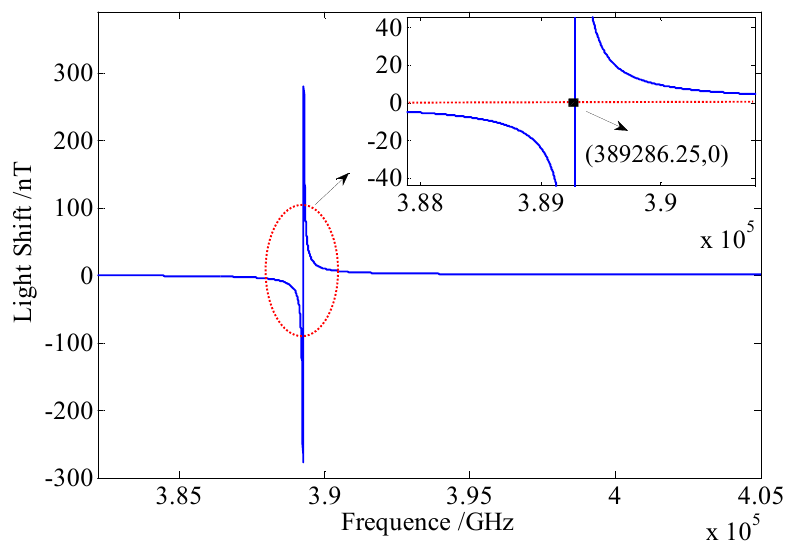
Figure 4. Simulation of the relation between the light shift and the frequency of the pump laser. The power of the pump laser is 100 mW, and the frequency at the resonant peak of potassium atom is 389,286.25 GHz.